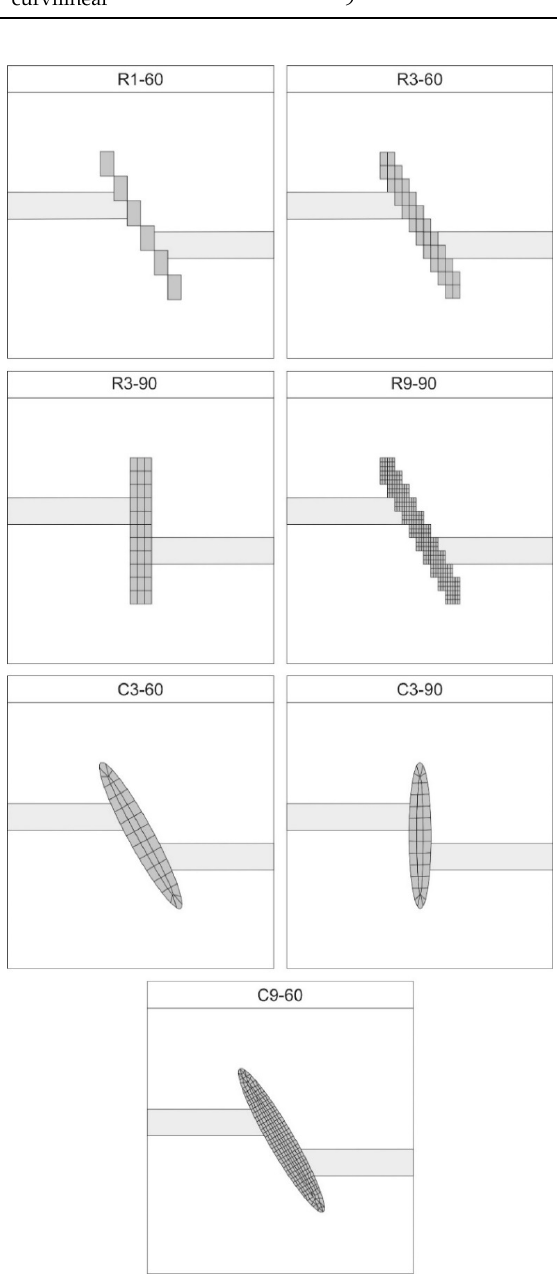
Figure 2. Images (not to scale) showing the basic differences between the seven scenarios studied regarding grid geometry, mesh resolution of the fault zone and fault dip.